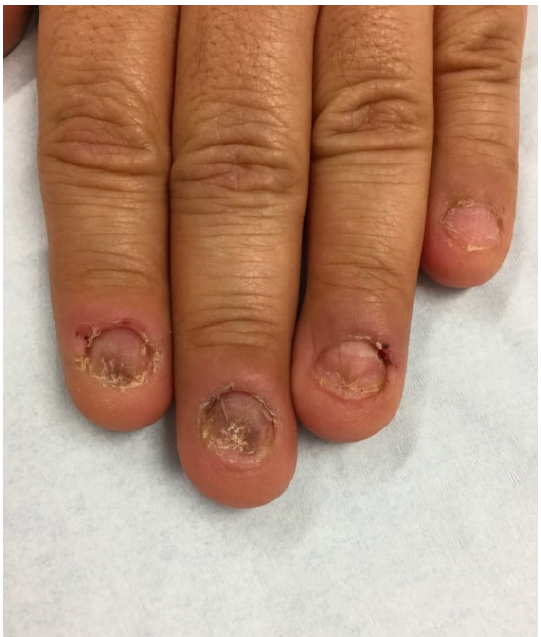
Figure 2. A 46-year-old nail biter with short, uneven nails and ragged cuticles. Nail folds are ery- thematous and in different stages of